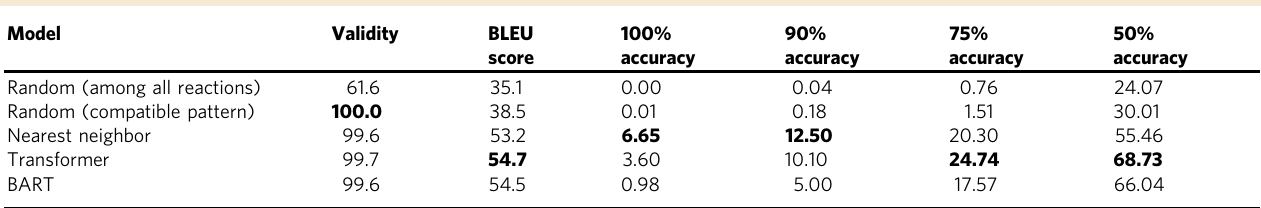
Table 3 Metrics for the prediction of synthesis actions.